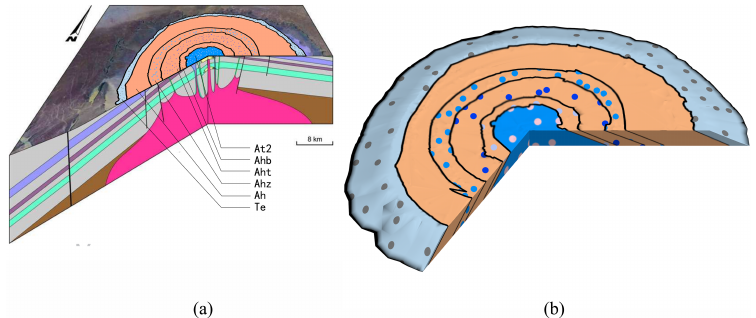
Figure 17. Richat structure vertical cut model based on different methods: ( a ) Perspective view of Richard structure [54]; ( b ) the vertical section model of Richard